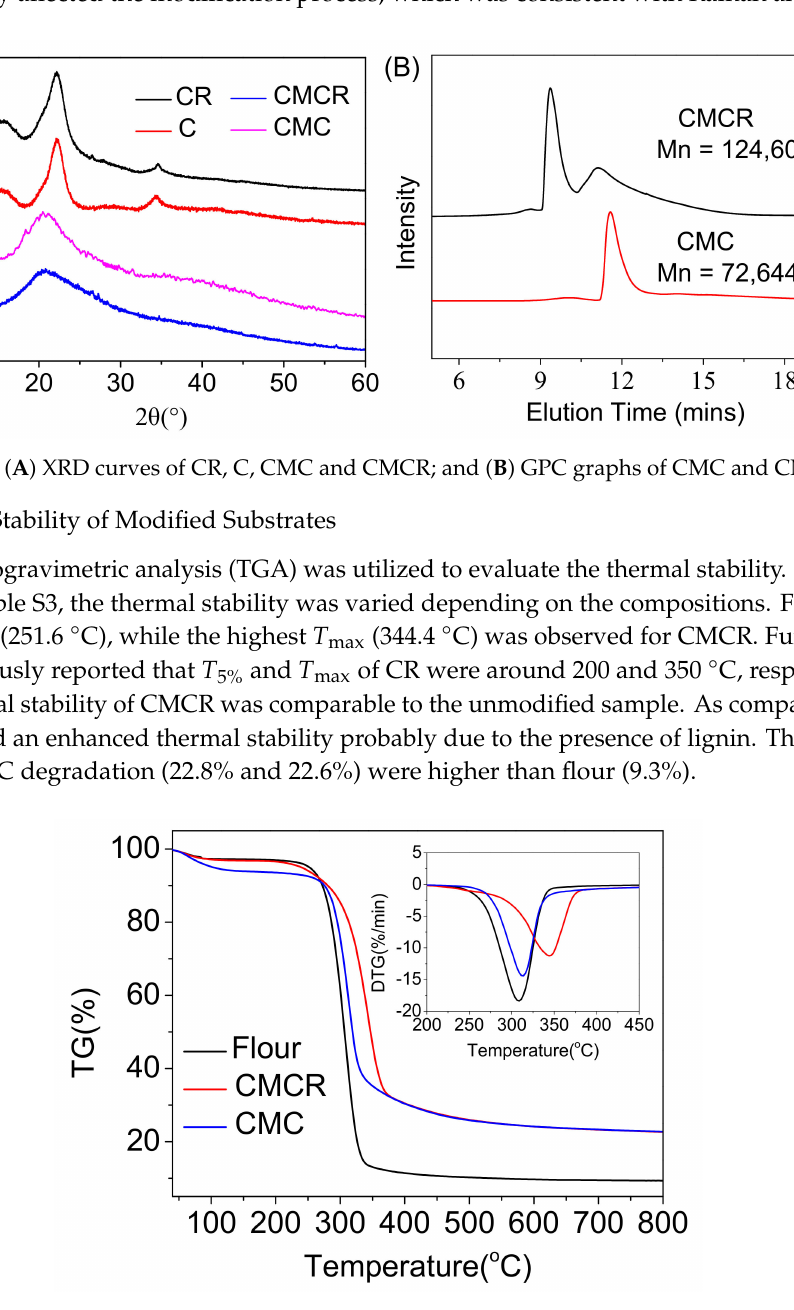
Figure 3. TGA analysis of flour, CMCR and